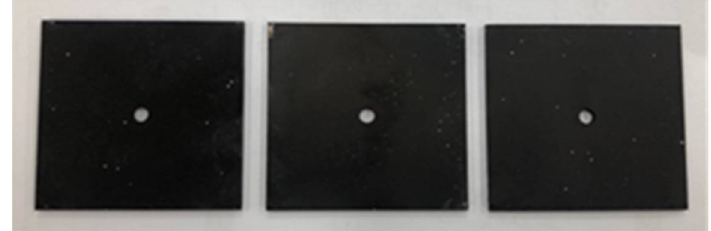
Figure 2. SS 304 specimens with a simulated corrosion oxide layer.